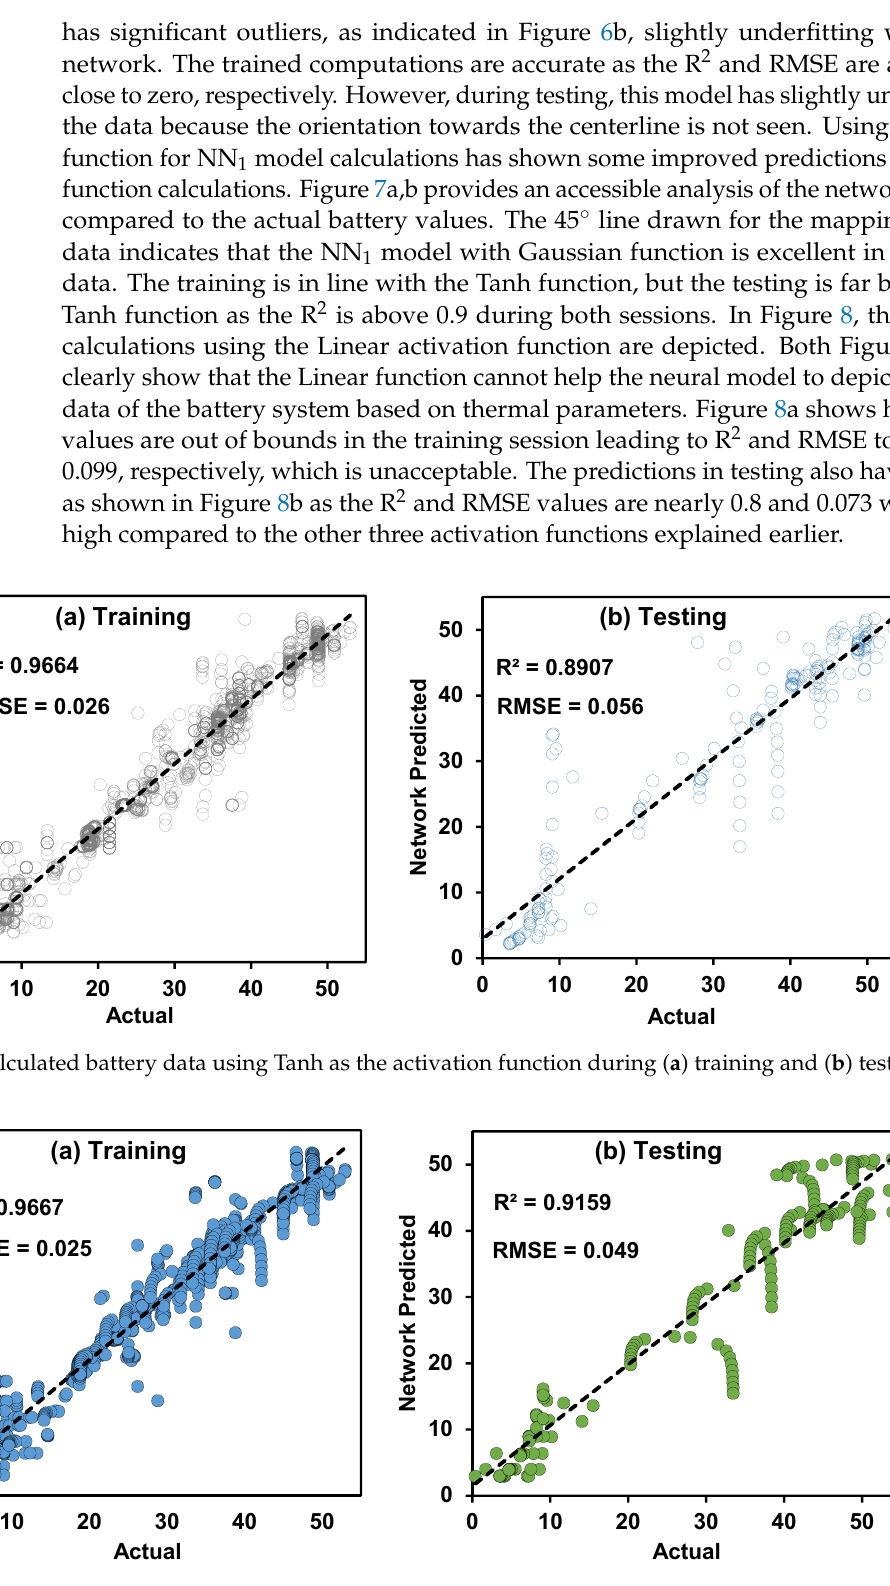
Figure 7. Gaussian function operated NN 1 model in ( a ) training and ( b ) testing.